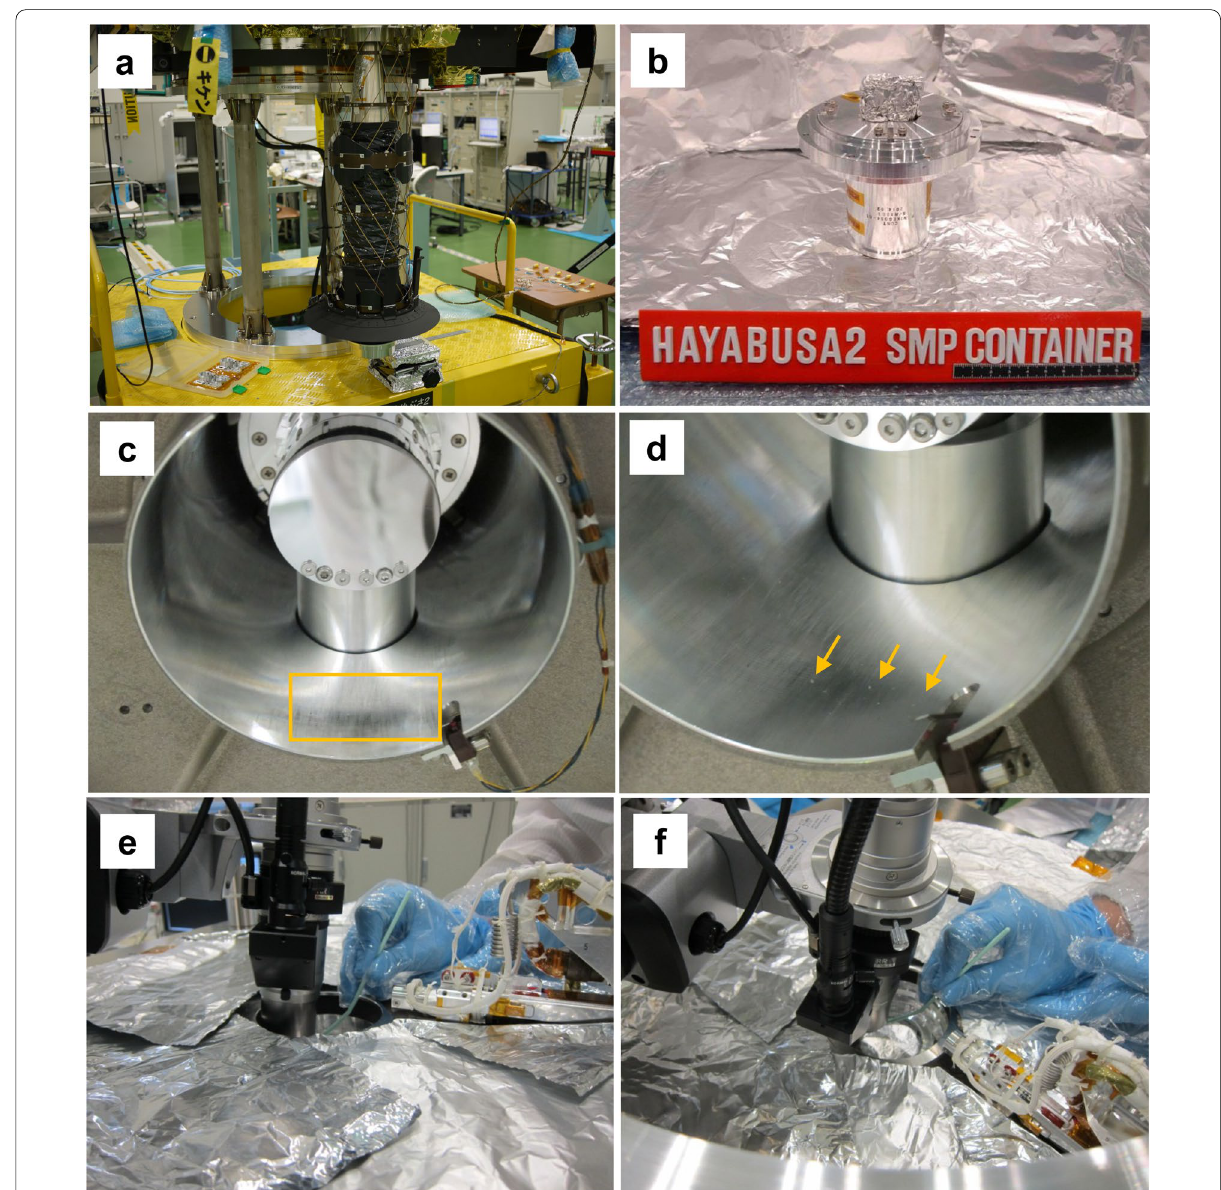
Fig. 3 Environmental monitoring near the Hayabusa2 spacecraft. a Sampler horn. b Sample container with witness coupon inside (Sawada et al. 2017). c , d Inside the sample catcher before elimination of surface dust. e , f Microscopic observation using a wipe stick to see if any artefacts were